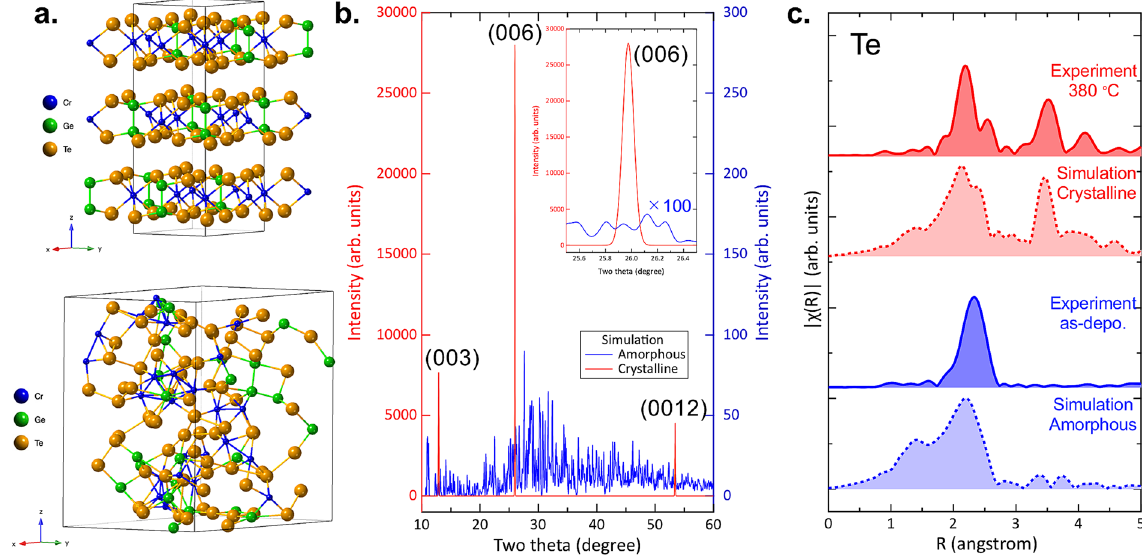
Figure 2. ( a ) (Top) Ideal crystal structure and (Bottom) simulated amorphous model. ( b ) Simulated XRD patterns of both phases. Inset magnifies the two theta range corresponding to the 006 reflection. ( c ) Simulated EXAFS spectra for comparison with the experimental